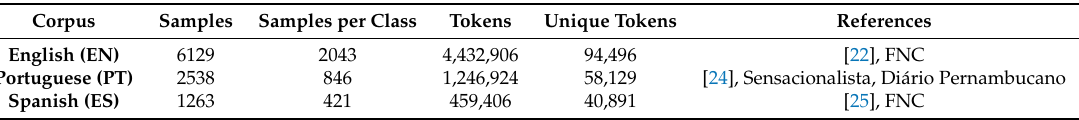
Table 2. Corpora information summarising characteristics for English, Portuguese, and Spanish datasets. FNC = Fake News Corpus.